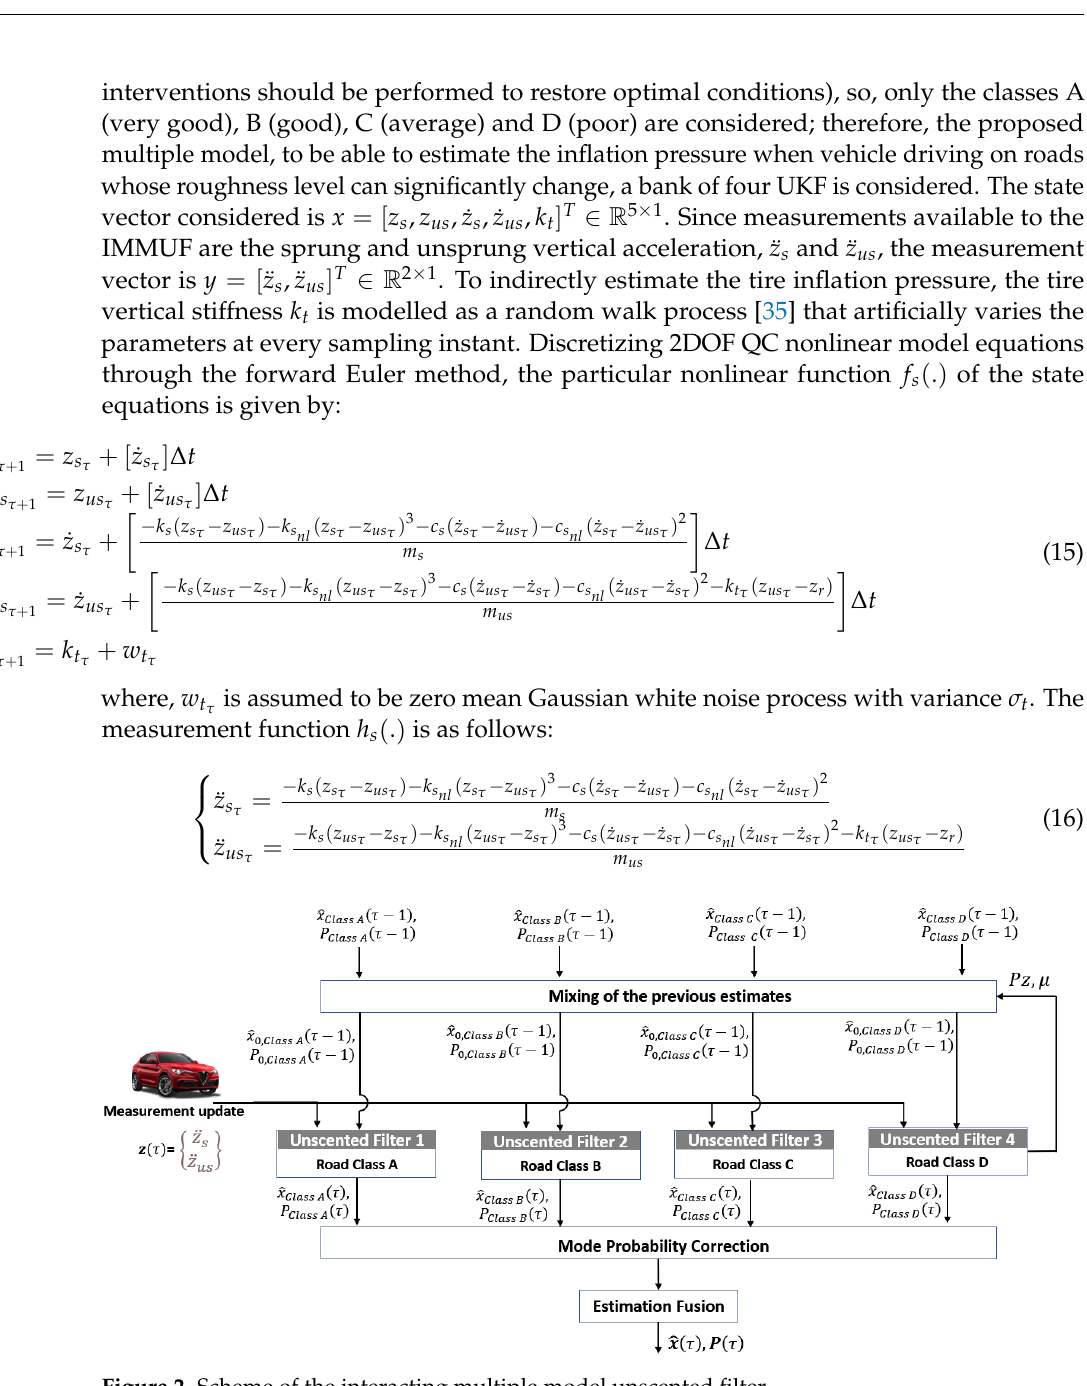
Figure 2. Scheme of the interacting multiple model unscented